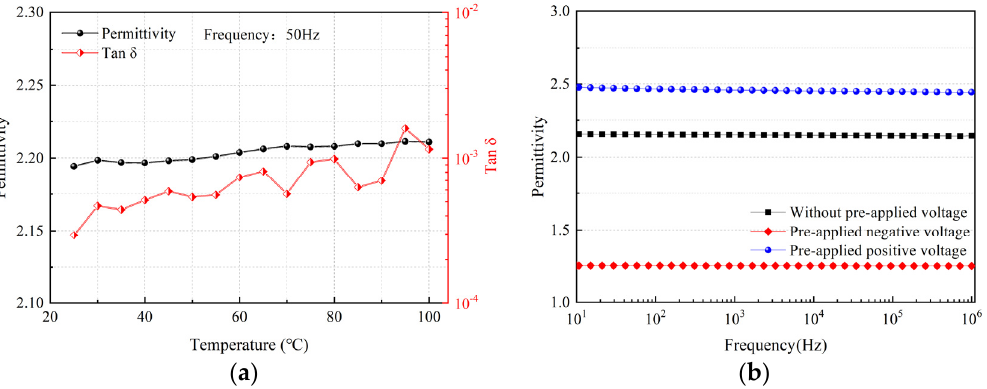
Figure 5. The change in permittivity of PP before and after pre-injected space charge: ( a ) the change in permittivity and dielectric loss of PP with temperature before pre-injected charge; ( b ) the change in permittivity of PP with frequency after pre-injected charge.